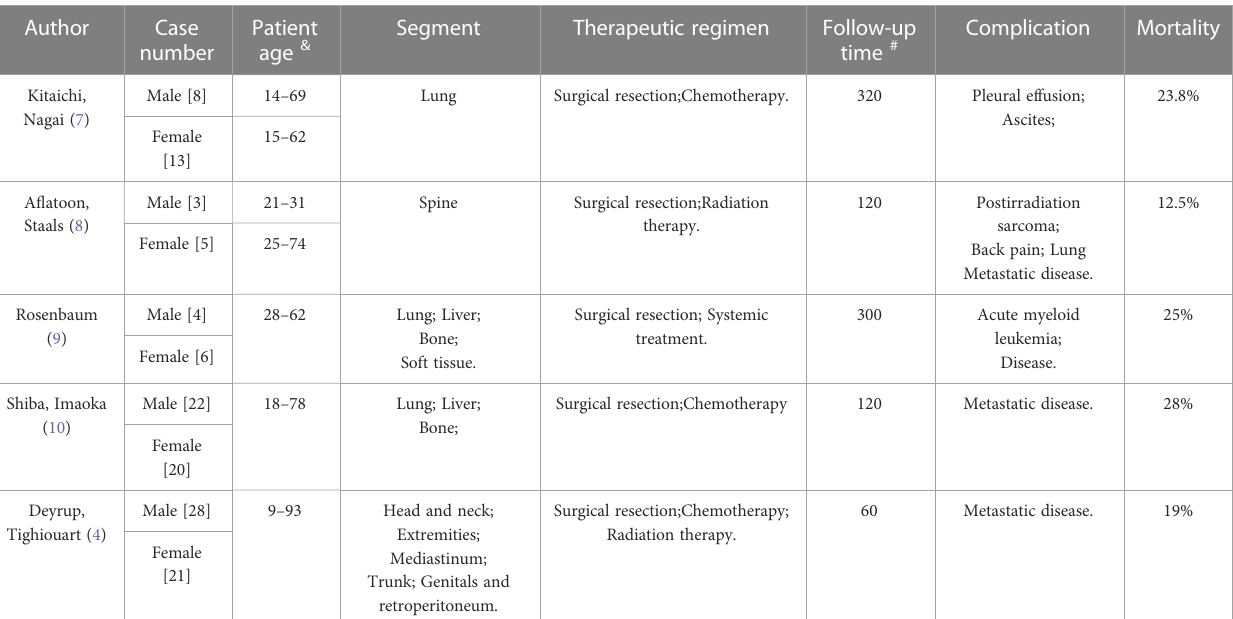
TABLE 1 Complications and mortality of EHE in the references of other